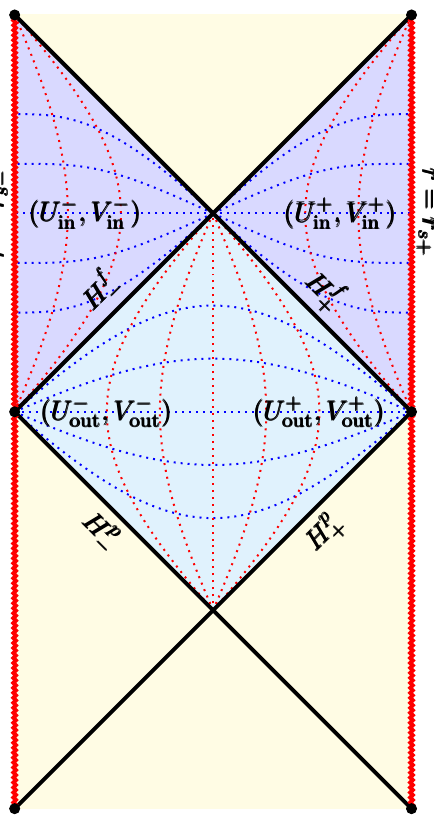
Figure 6 . The red dotted lines are constant r , the blue dotted lines are constant time. The central part is the exterior of the black holes. H f are the future horizons of the left ( − ) and right ( + ) black ± holes. H p are the past horizons. The darker sectors are the internal regions of the two black holes, ± the red waved lines are the timelike singularities. The yellow regions are periodic